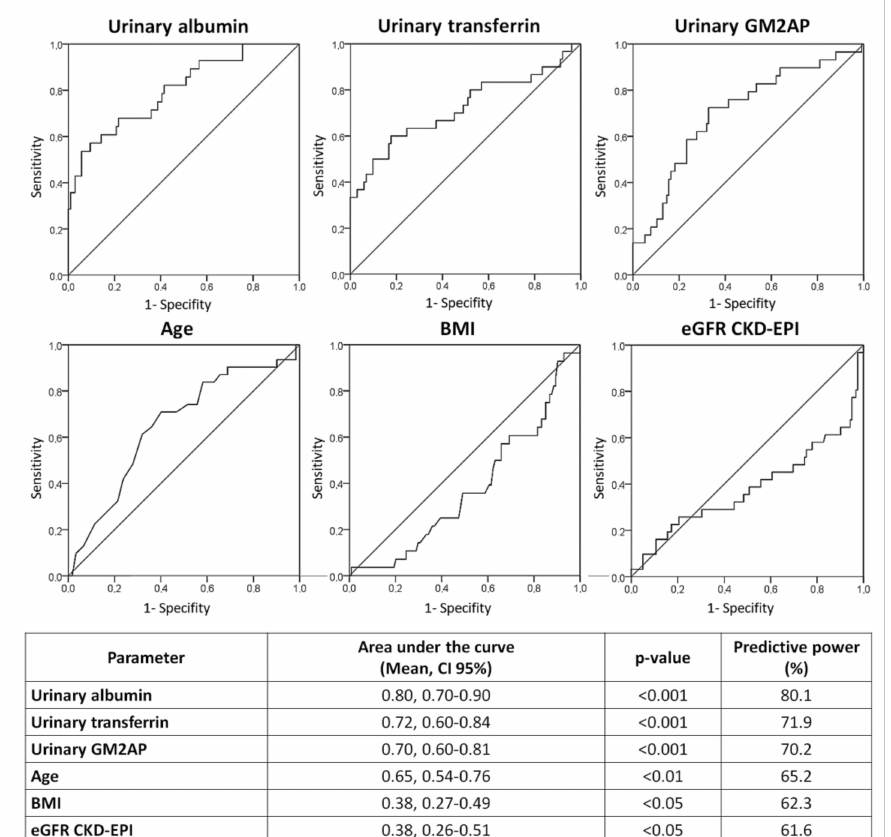
Figure 2. ROC curves for age, BMI, eGFR CKD-EPI and urinary albumin, transferrin and GM2AP. BMI: body mass index; CI 95%: 95% confidence interval; CKD-EPI: Chronic Kidney Disease Epidemi- ology Collaboration; eGFR: estimated glomerular filtration rate; GM2AP: GM2 ganglioside activator